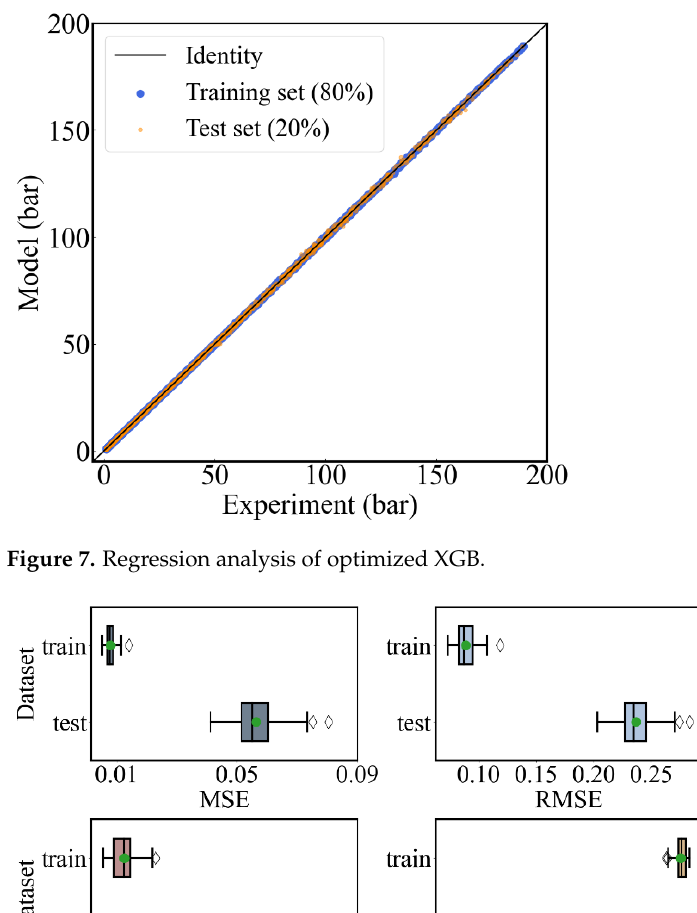
Figure 6. Iterative process of SSA.